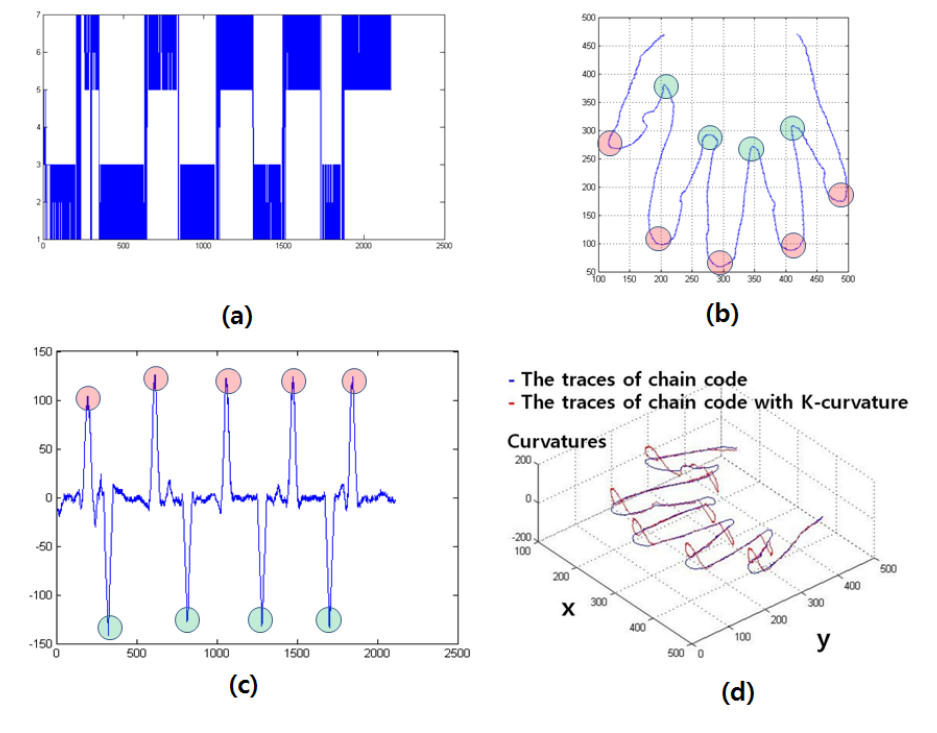
Figure 7. ( a ) the chain code; ( b ) traces of the chain code; ( c ) K-curvature, and ( d ) trace of the chain code with